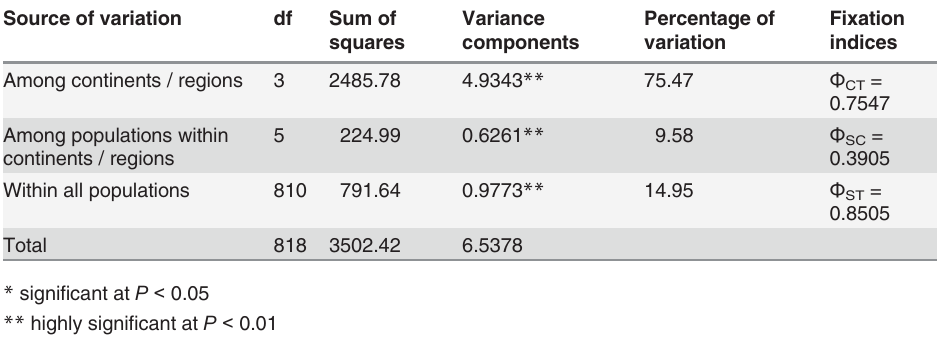
Variance squares components